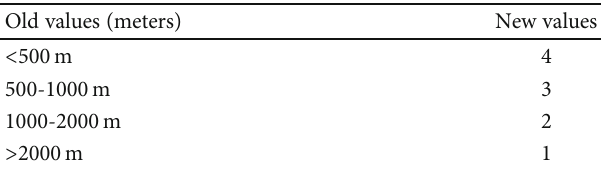
Figure 8: Suitable stream distance for solar PV. Table 12: Stream reclassi fi cation. Table 13: Forest reclassi fi